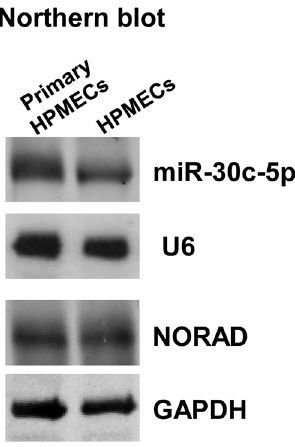
Figure A1: Northern blot results of NORAD and miR - 30c - 5p expres - sions. Isolated primary pulmonary microvascular endothelial cells and HPMECs cell line were subjected to Northern blot analysis. U6 and GAPDH were internal controls for miR - 30c - 5p and NORAD.